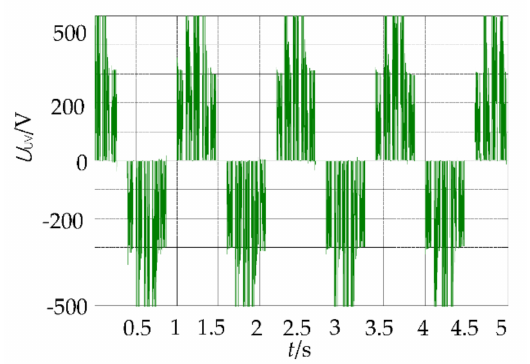
Figure 8. Line voltage waveform of functional